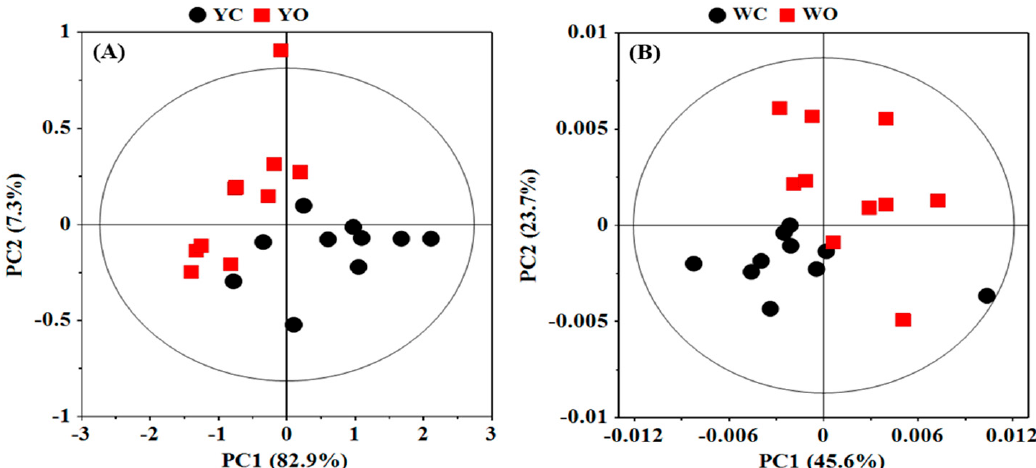
Figure 2. Principal component analysis (PCA) scores plots based on 1 H NMR spectra of egg yolk ( A ) and egg white ( B ) obtained from conventional and organic eggs. YC: egg yolk from conventional eggs; YO: egg yolk from organic eggs; WC: egg white from conventional eggs; WO: egg white from organic eggs.